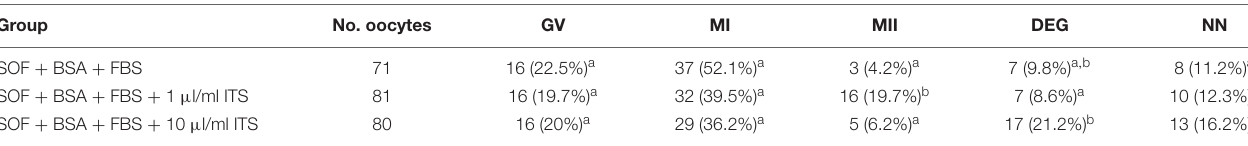
TABLE 2 | In vitro maturation of canine oocytes for 72 and 48 h in three different media under high O 2 atmosphere. Group Time IVM No. oocytes GV MI MII DEG NN TCM-199 + FBS 72 73 16 (21.9%) a 24 (32.8%) a 48 SOF + BSA + FBS 48 SOF + BSA 72